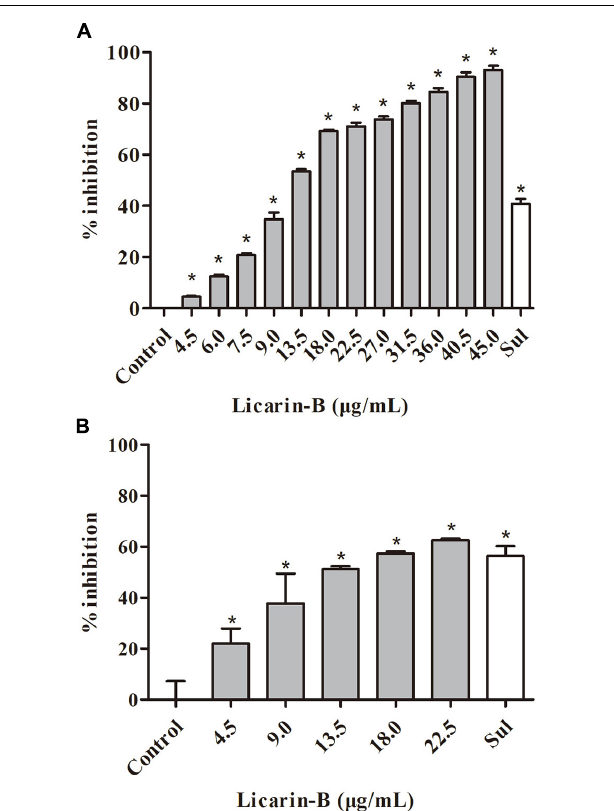
FIGURE 2 | Licarin-B inhibited T. gondii tachyzoite intracellular proliferation and invasion in vitro . (A) Assessment of the anti-proliferative effect of licarin-B on T. gondii -infected HFFs by qPCR. HFFs were infected with T. gondii and then cultured in DMEM with licarin-B (4.5, 6, 7.5, 9, 13.5, 18, 22.5, 27, 31.5, 36, 40.5, or 45 µ g/mL), sulfadiazine (0.4 µ g/mL), or no drug (parasite control). After 24 h, a 529-bp repeat element of the T. gondii genome was amplified by PCR. The percent inhibition of tachyzoite proliferation in each group was compared with that in the parasite control group. (B) Effects of licarin-B on T. gondii invasion. HFFs were cultured in DMEM containing licarin-B (4.5, 9, 13.5, 18, or 22.5 µ g/mL), sulfadiazine (0.4 µ g/mL), or no drug (parasite control) and infected with T. gondii tachyzoites. The anti-invasion capability of licarin-B was determined by qPCR after 2 h of infection. The percentage of invasive cells is expressed as the number of infected cells compared with the total number of host cells. Triplicate independent experiments were performed, and the data are presented as the mean ± SD. * p < 0.01 compared with the parasite control.